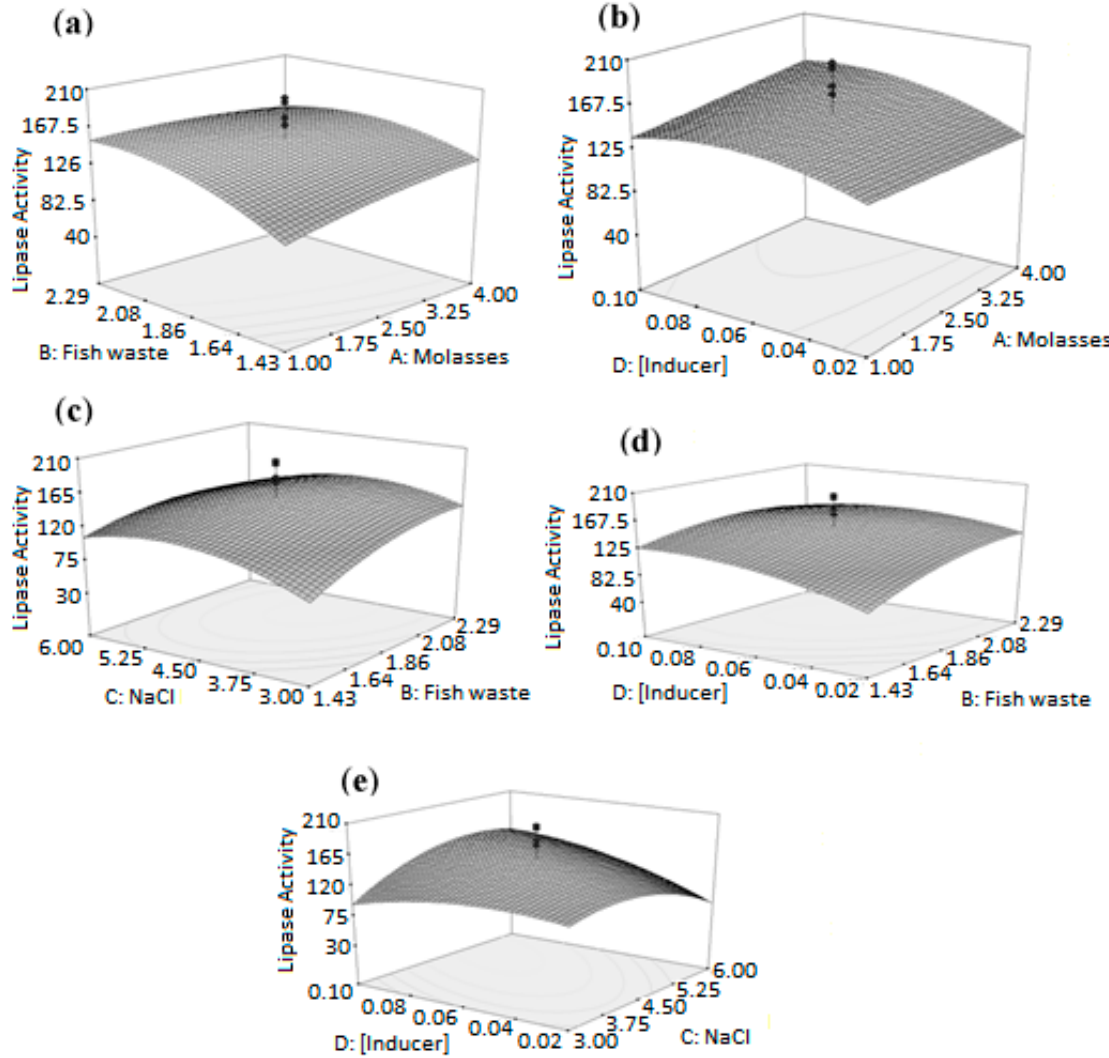
Figure 2. Response surface 3D contour plots for the effects of four main variables on T1 lipase activity shown in ( a ) fish waste ( B ) versus molasses ( A ), ( b ) inducer ( D ) versus molasses ( A ), ( c ) NaCl ( C ) versus fish waste ( B ), ( d ) inducer ( D ) versus fish waste ( B ), and ( e ) inducer ( D ) versus NaCl ( C